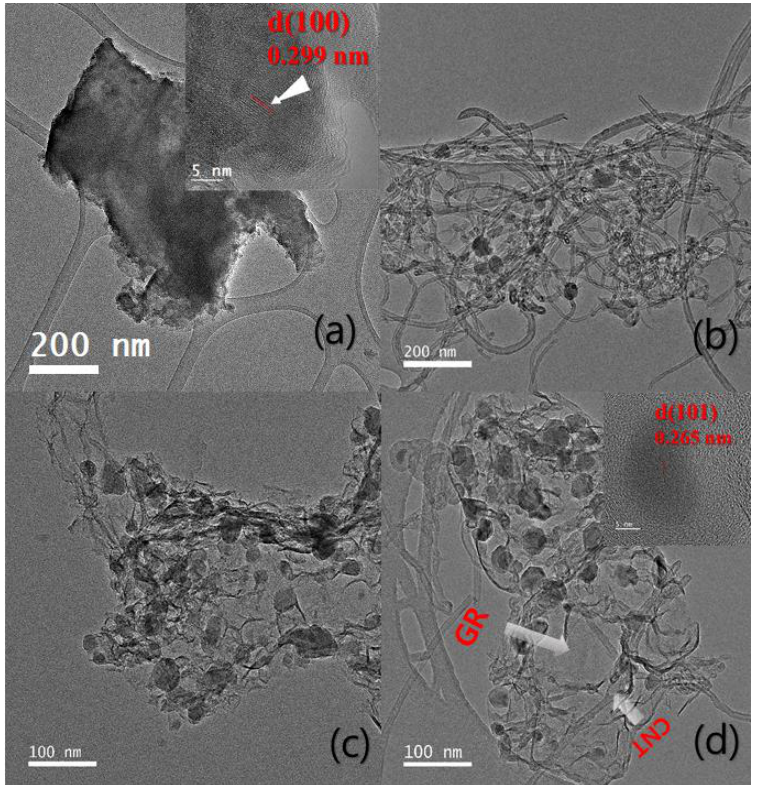
Figure 1. TEM images of ( a ) bare FeS, ( b ) FeS/N,S:CNT,( c ) FeS/N,S:GR, and ( d ) FeS/N,S:CNT – GR.